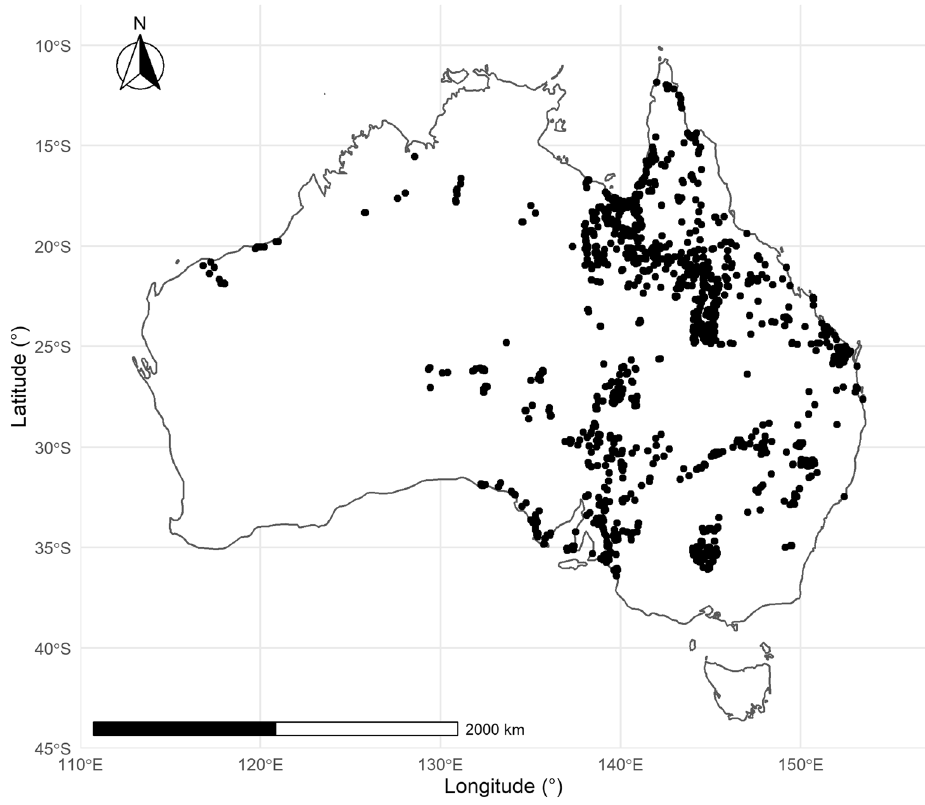
Figure 4. Australia with the sample site locations shown in black.